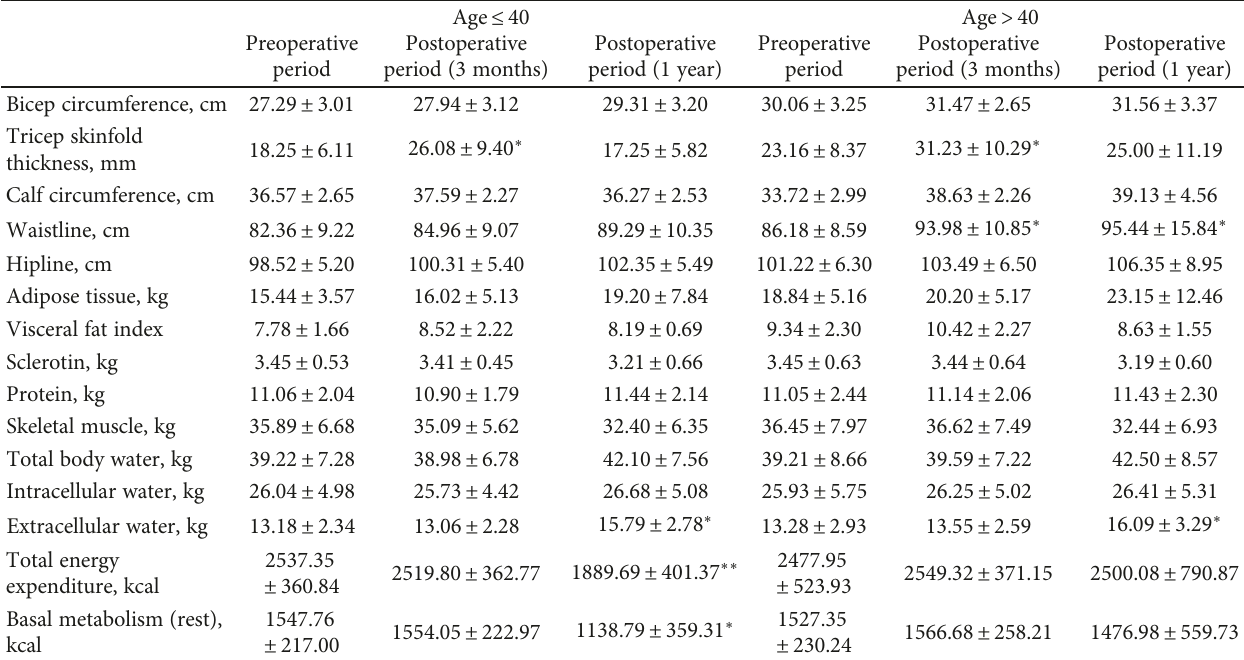
Table 4: Body composition and metabolic changes in the acromegaly patients according to